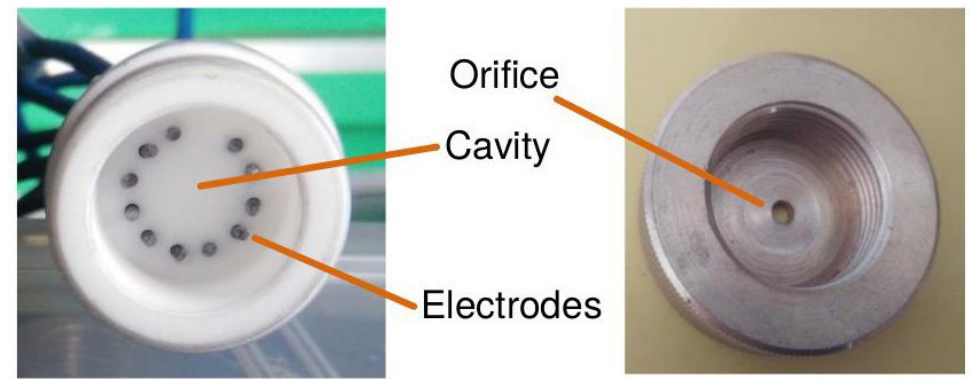
Figure 11. 11-electrode SparkJet. Reprint from [54] with permission from Elsevier.